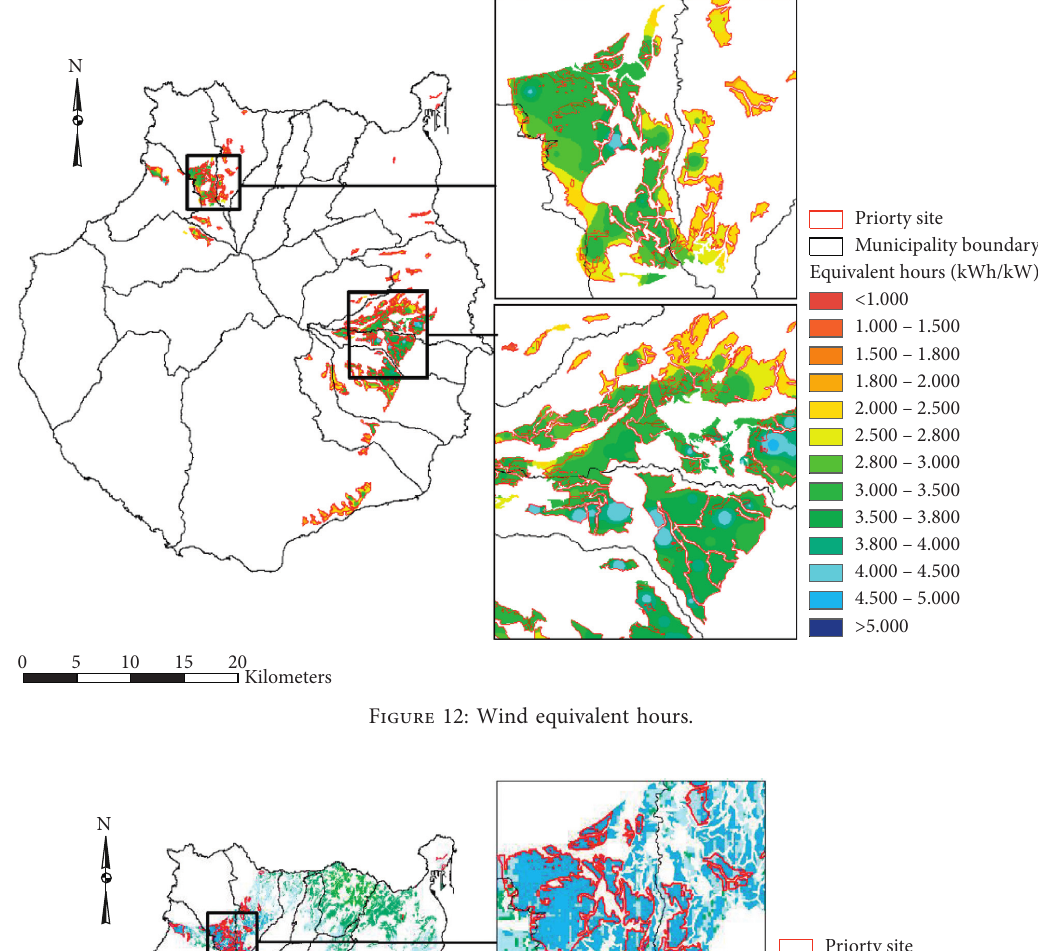
Figure 12: Wind equivalent hours.